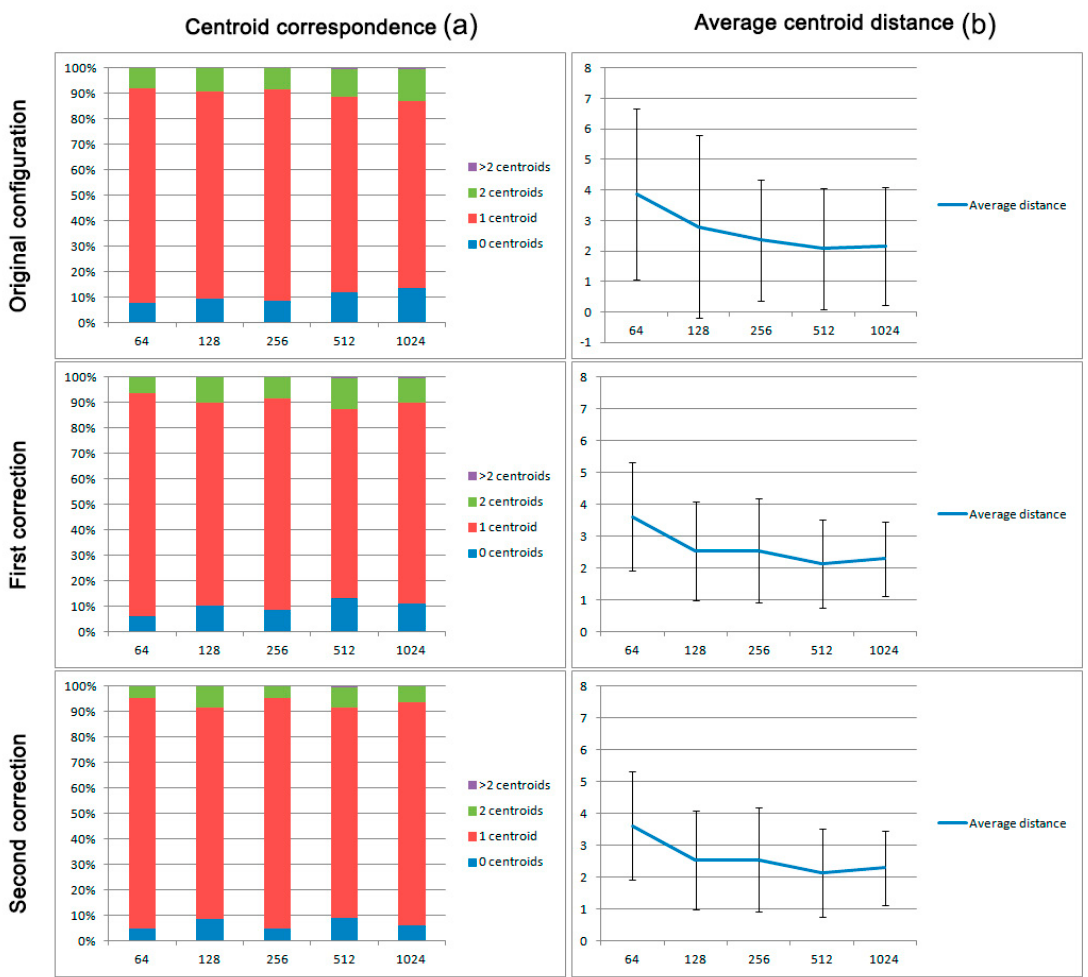
Figure 9. Number of correspondences (closer centroids) between each ideal centroid and the real ones ( a ). Standard deviation and average distance from the centroid to the geometrical center of the regions ( b ).